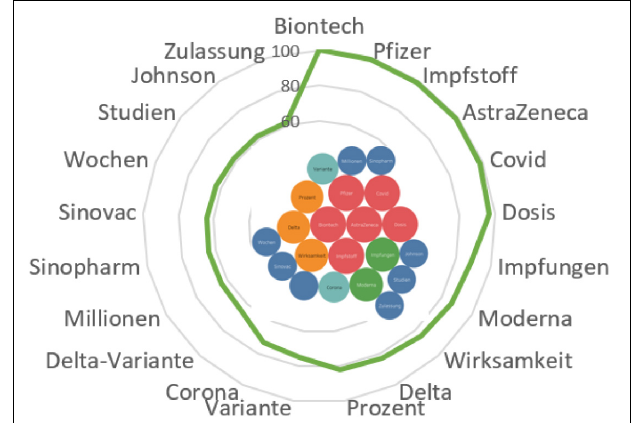
FIGURE 5 | Associative network of the stimulus